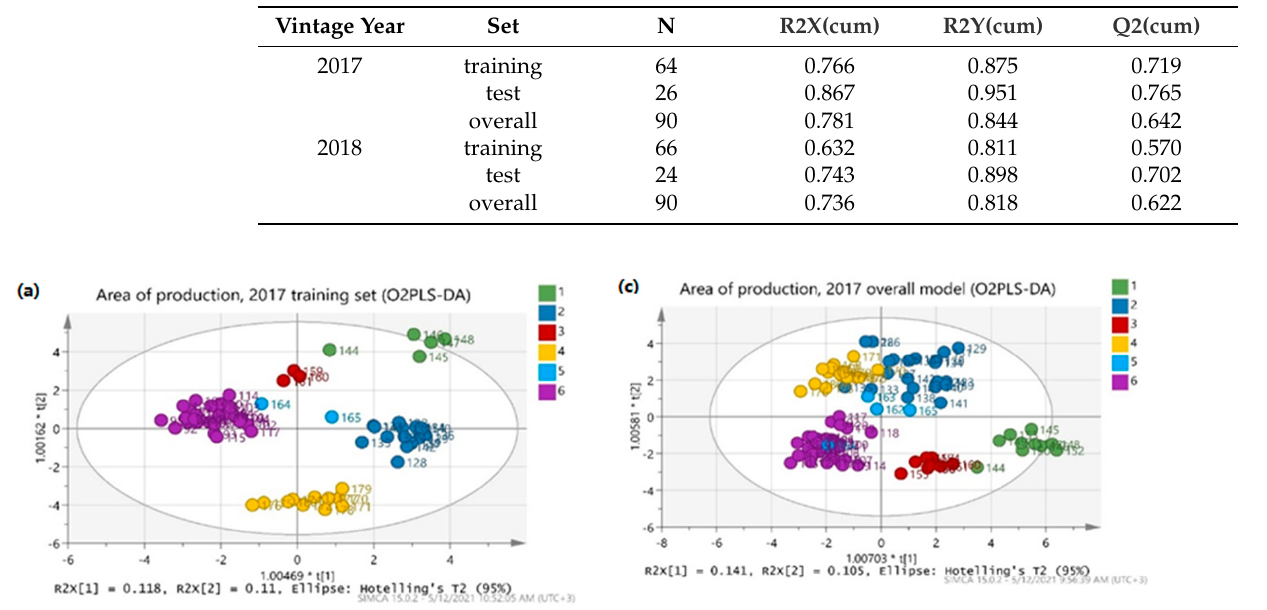
Table 10. The R2X(cum), R2Y(cum), and Q2(cum) scores of classifications for the wine samples between 2017 to 2018 regarding area of production by O2PLS-DA.